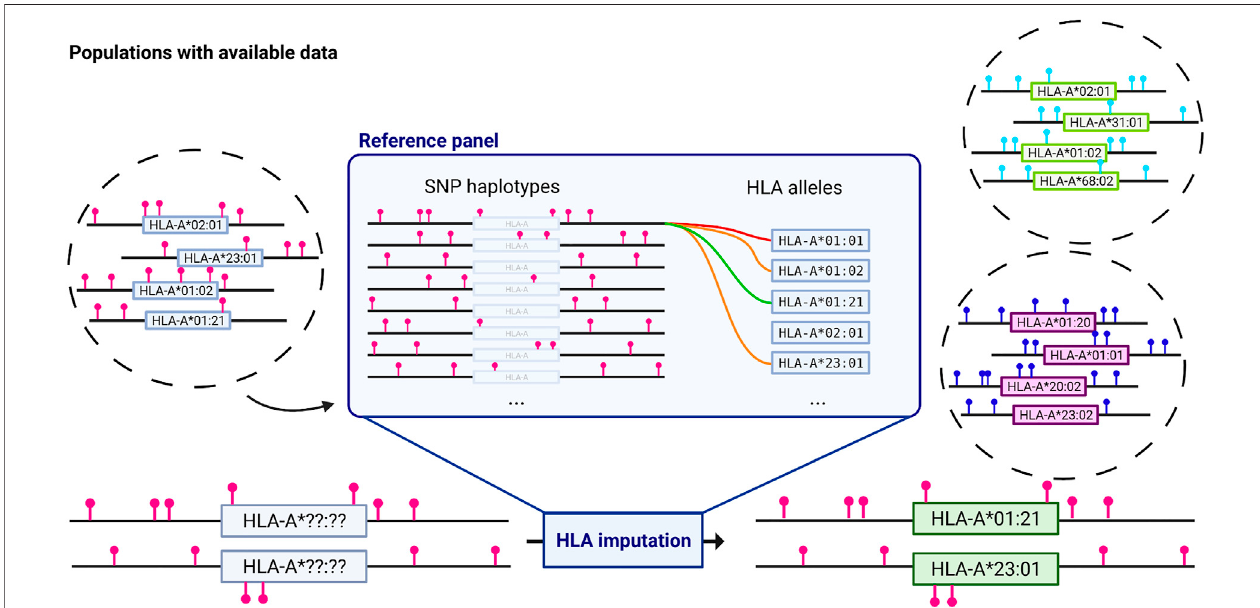
FIGURE 2 | HLA imputation from GWAS data. Reference panels are created from individuals with known SNP and HLA data. Depending on the method, an algorithm will deduce the probability of a speci fi c HLA allele in the population given a SNP haplotype. These new found links are stored for that reference panel and applied to new SNP data to infer HLA genotypes. HLA-A is given as an example with a truncated list of alleles; other MHC genes are imputed using the same method. Different populations are represented in different circles and imply different allele frequencies. Pinpoints represent SNPs and are only indicative. HLA imputation results are highly dependent on the population chosen for the reference panel. Created with